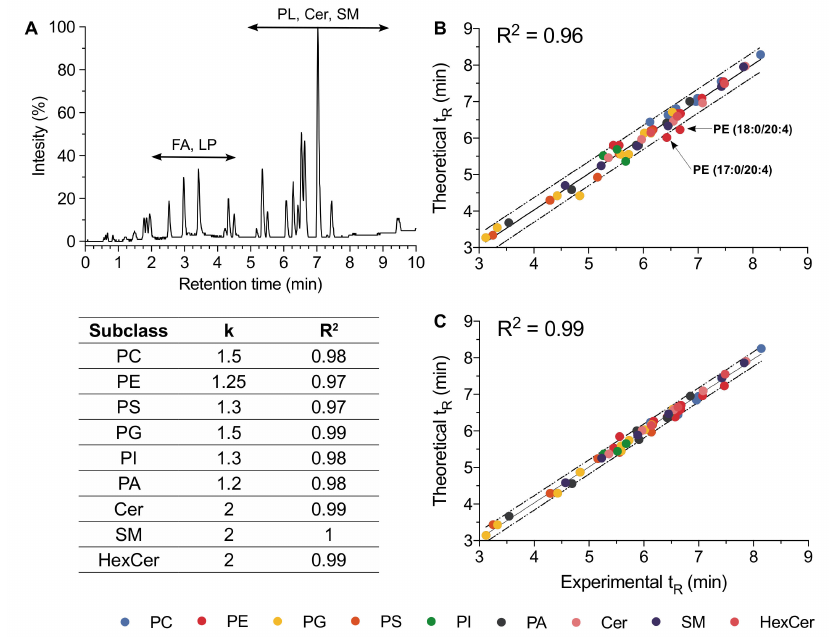
Figure 3. Retention time prediction model based on equivalent carbon number (ECN) of nine subclasses of phospholipids and sphingolipids. ( A ) UHPLC-HRMS chromatogram of a commercial standard lipid mixture in the negative ion mode. ( B ) Theoretical t R plotted against experimental t R for standard lipid mixture before and ( C ) after k value fitting. A linear (phospholipids) and polynomial (sphingolipids) regression model was used. Dotted lines represent the 95% confidence interval displaying a relative error which reached 15% on the linear regression graph (B) (k = 2) and did not exceed 5% on the linear regression graph (C). Table: Parameters of relationship between ECN and experimental t R determined using a standard lipid mixture. The general expression of ECN is ECN = NC - k × DB where NC and DB are the total number of carbons and the number of double bonds, respectively. PC: phosphatidylcholine, PE: phosphatidylethanolamine, PG: phosphatidylglycerol, PS: phosphatidylserine, PI: phosphatidylinositol, PA: phosphatidic acid, Cer: ceramide, SM: sphingomyelin, HexCer: hexosyl